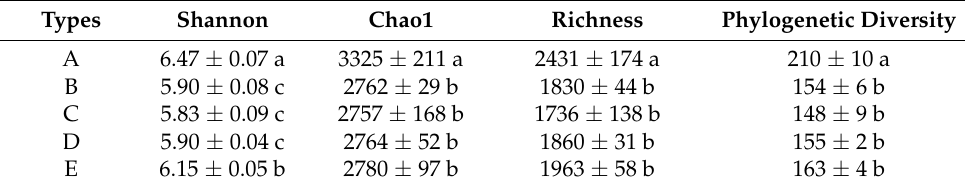
Table 1. Alpha diversity of soil bacterial community.